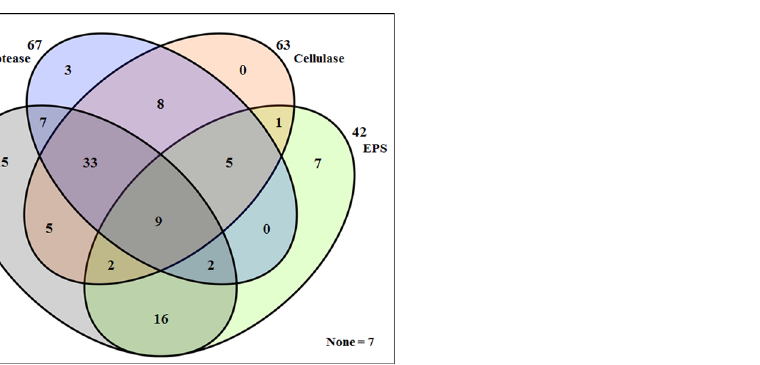
Fig 4. Venn diagram showing the spore association characters of SAB isolated from 0, 10 and 20 min disinfected spores.